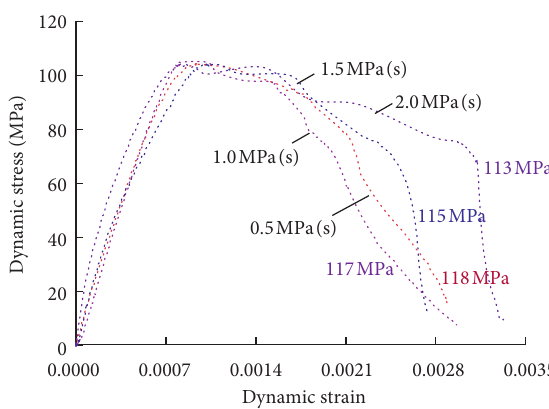
Figure 5: Dynamic stress-strain envelope curve (axial load